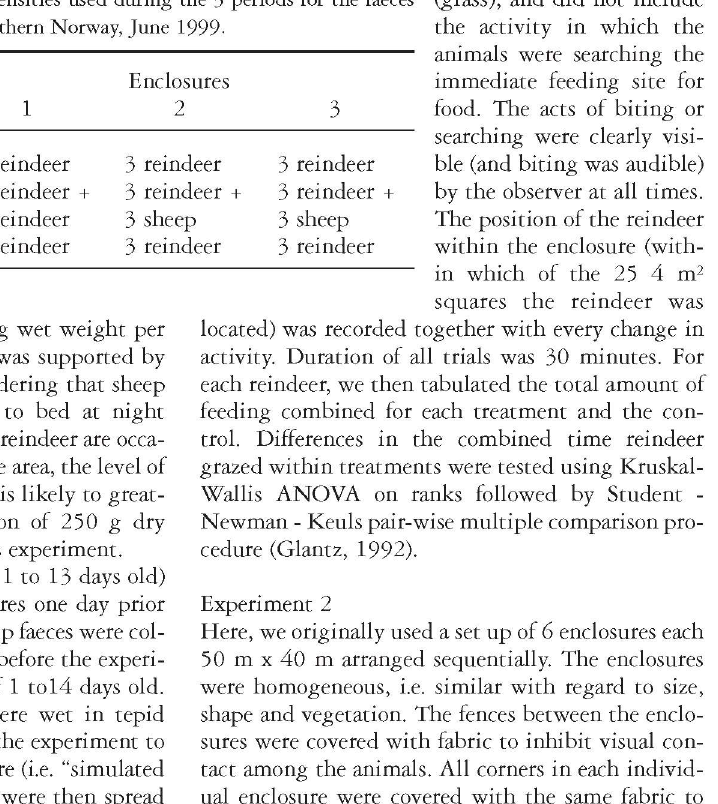
Table 1. The treatment and animal densities used during the 3 periods for the faeces distribution experiment, northern Norway, June